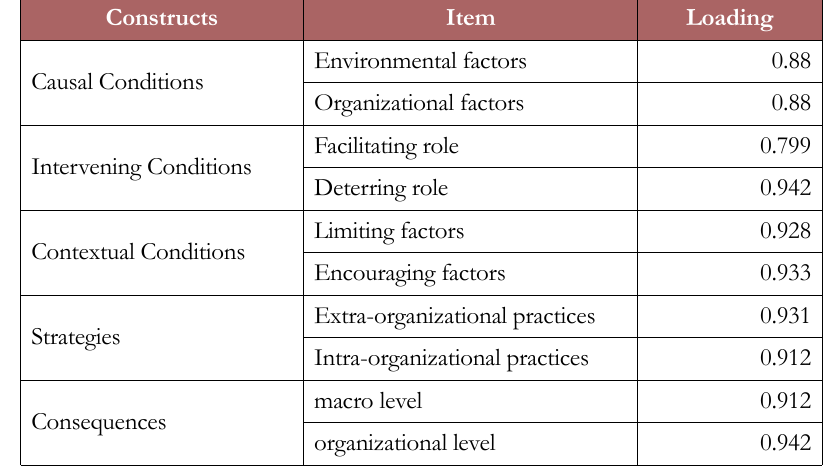
Table 10. Results of item